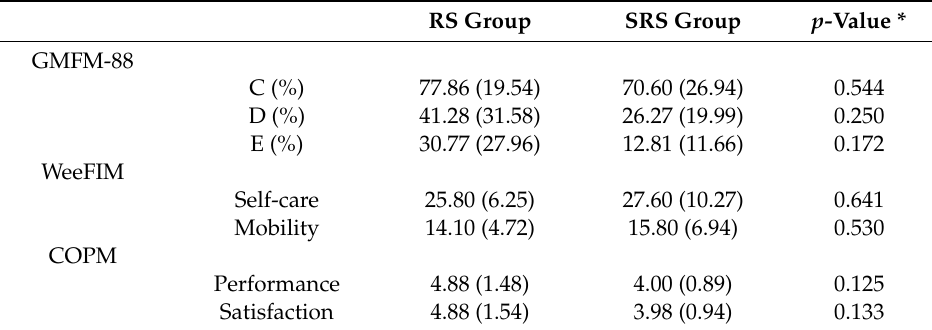
Table 3. Baseline functional characteristics of the